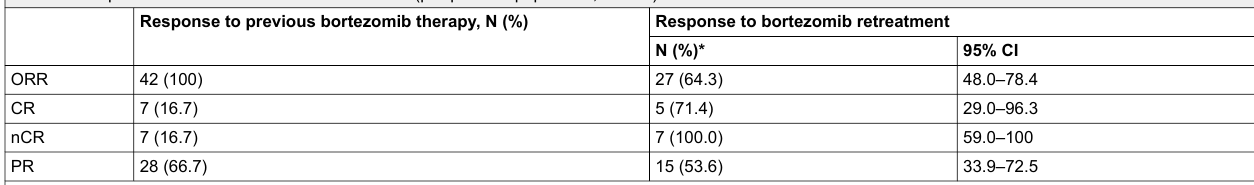
Table 4: Response rates to bortezomib retreatment stratified by response to initial bortezomib treatment (per-protocol population, N = 42). Best response to previous bortezomib